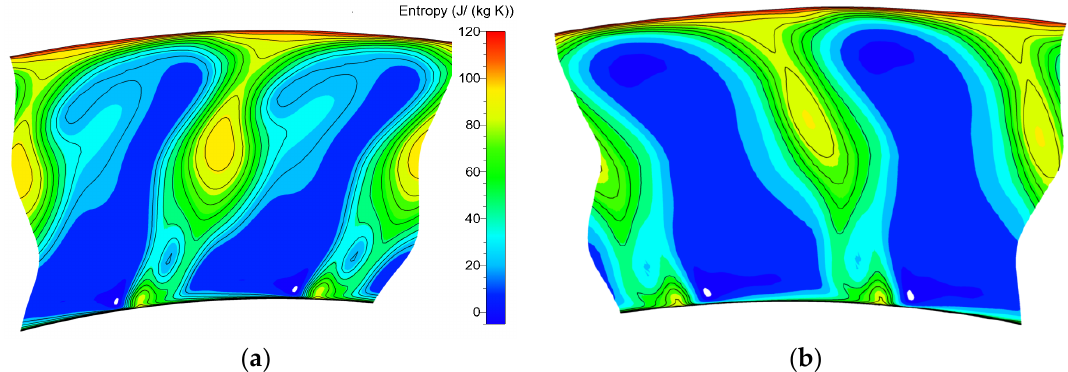
Figure 17. The entropy distribution of the S3 surface at the outlet of the original and optimized tandem rotor. ( a ) ORG; ( b ) OPT.